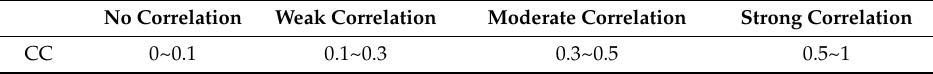
Table 1. The relationship between correlation coefficient (CC) and